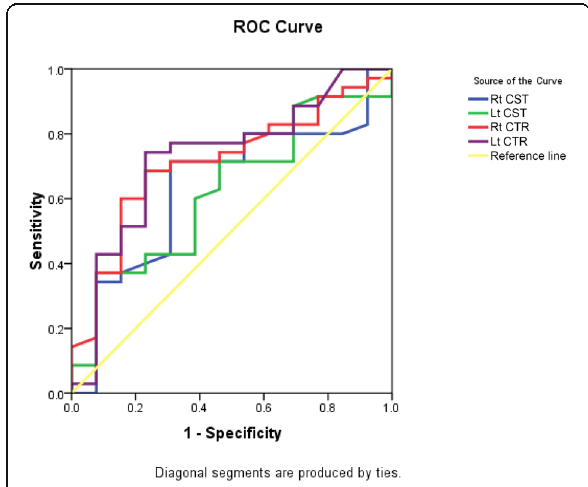
Fig. 2 ROC curve application for determination of sensitivity and specificity of MD values in (CST and CTR) in CP